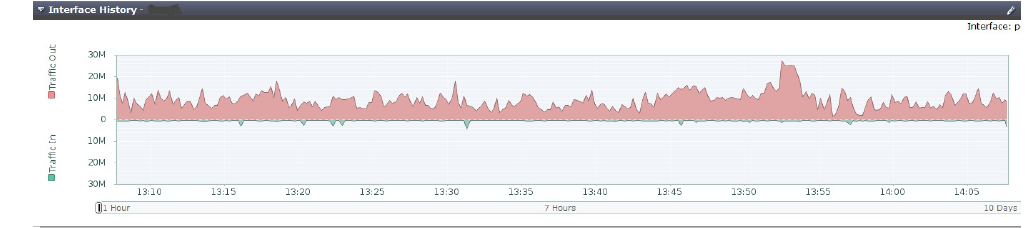
Fig. 3. Plot of the network data traffic during one hour (as provided by the firewall